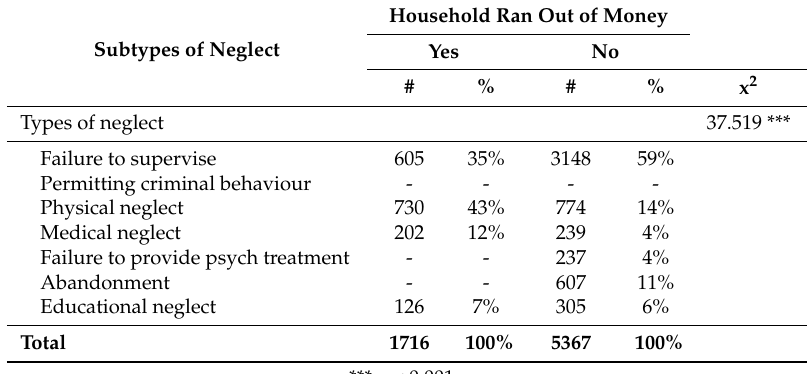
Table 6. Bivariate analysis for subtypes of substantiated neglect